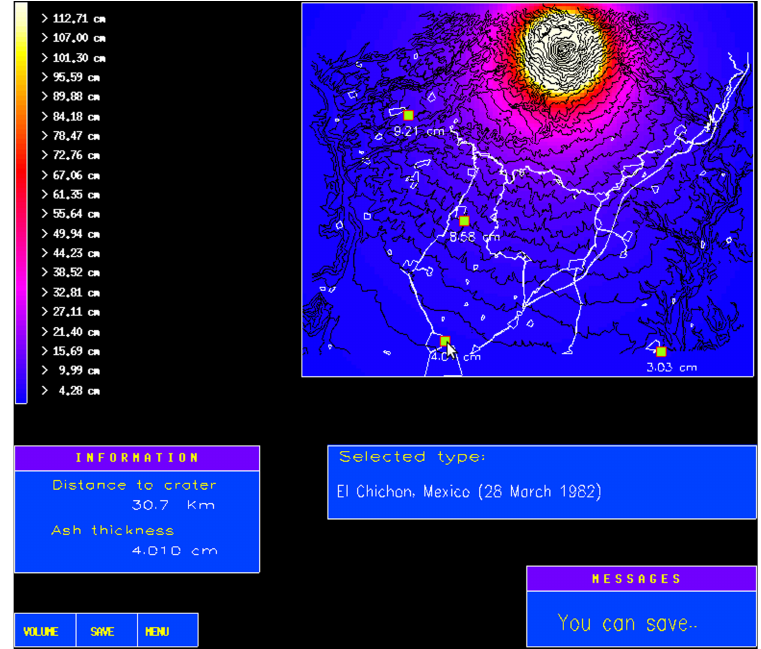
Fig. 9. SECCVO ashfall scenario of an eruption similar to the 28 March 1982 eruption of El Chich´on volcano occurring at Colima volcano, assuming a prevailing wind blowing towards Colima city (N 200 ◦ SW). This scenario displays the topography and the main towns and villages. The simulator estimates an ash thickness of 4cm in Colima City, 8.6cm in Suchitl´an, 3cm in Alzada and 9.2cm in San Jose del Carmen (Jalisco State). The program displays the ash thickness in any point selected with the cursor (Colima city in this example).